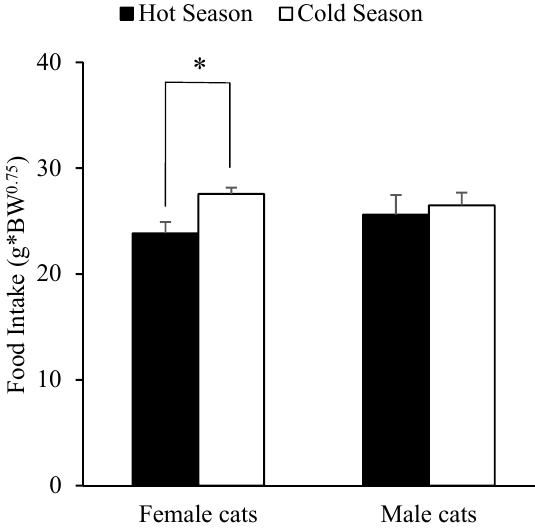
Figure 3. Cat’s food intake means and standard errors of most consumed diets (Diet A) after two feeder 20-h preference tests according to animal’s sex (females or males) and climate season (hot or cold). * p < 0.05.